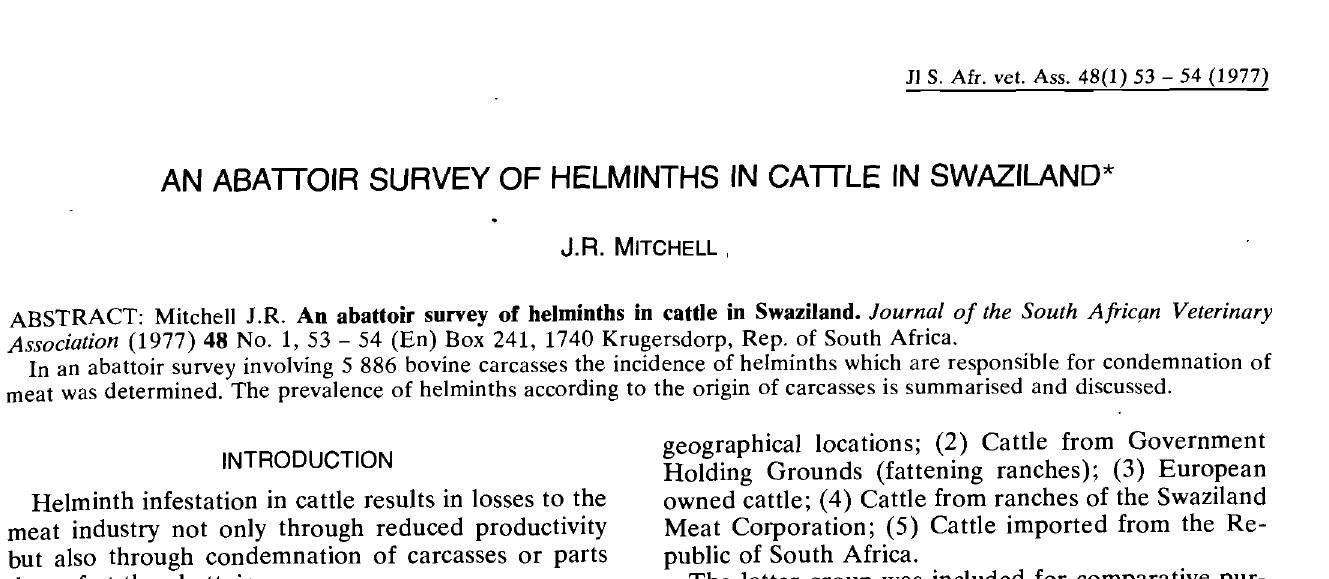
. C. bOllis Hydatid cysts O.